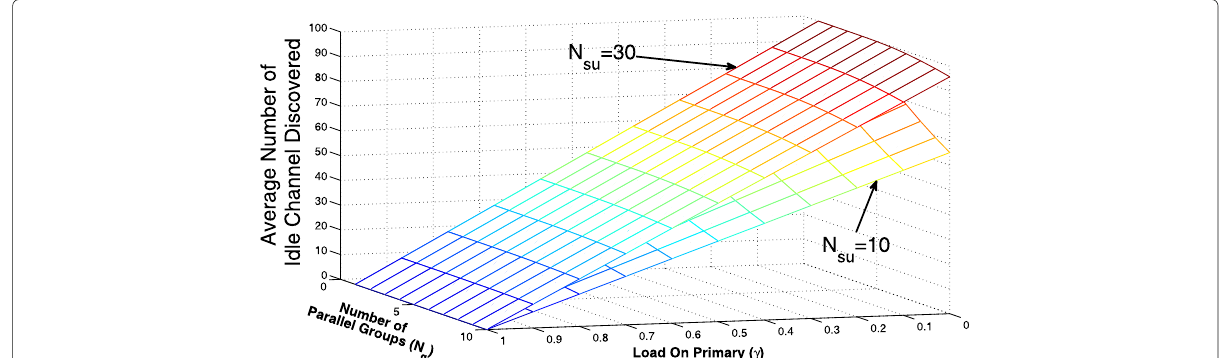
Fig. 6 Average number of idle channels discovered by SUs with variations in the number of parallel groups and traffic load on the primary band